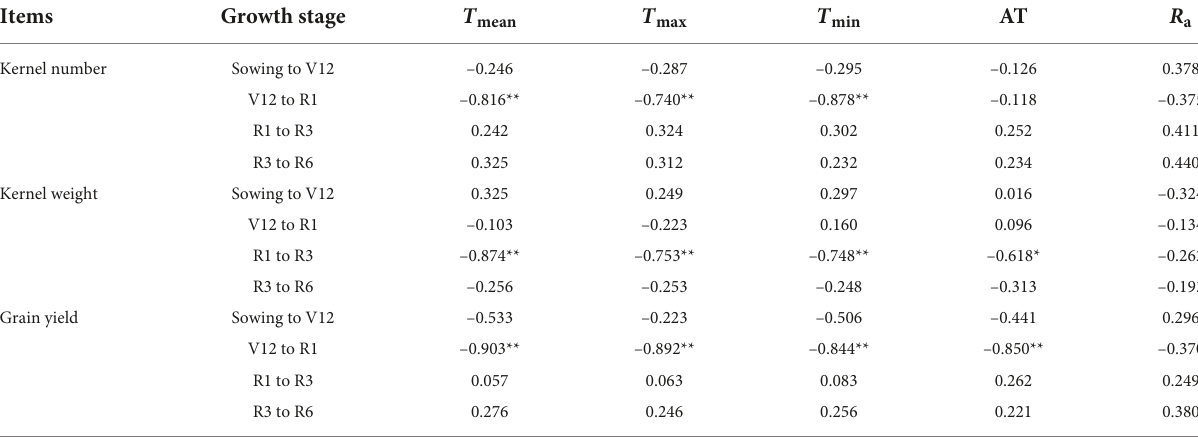
TABLE 4 Relationships between temperatures during maize growth stage and kernel number, kernel weight, and grain yield.